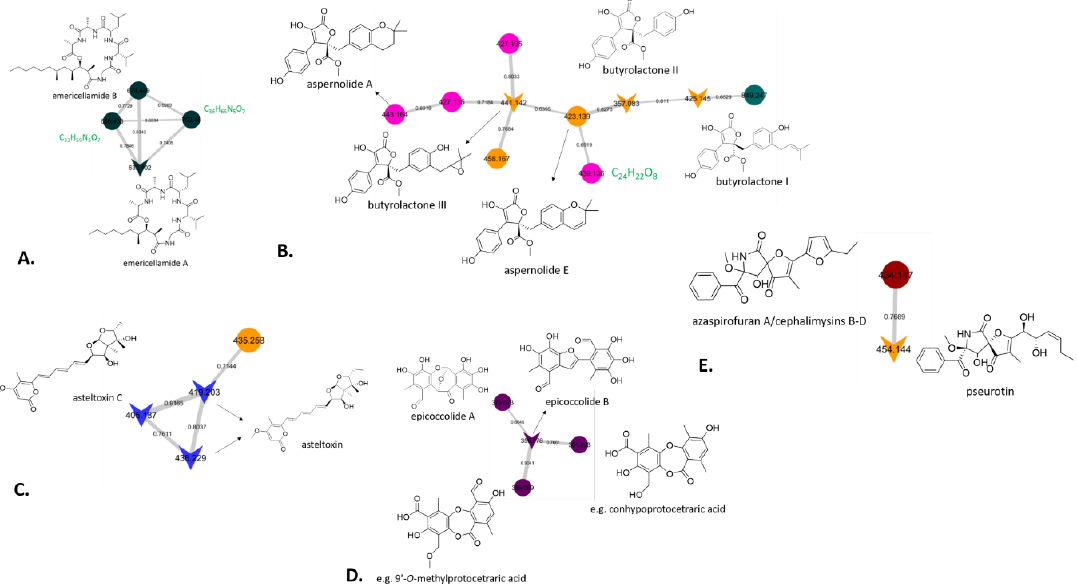
Figure 3. Selected GNPS clusters representing molecular families: ( A ) emericellamide cluster, ( B ) butyrolactone cluster, ( C ) asteltoxin cluster, ( D ) epicoccolide cluster, and ( E ) pseurotin cluster. Nodes depicted by inverted triangular shapes represent hits in the GNPS compound library. Candidate molecular formulae for potential new derivatives highlighted in green.